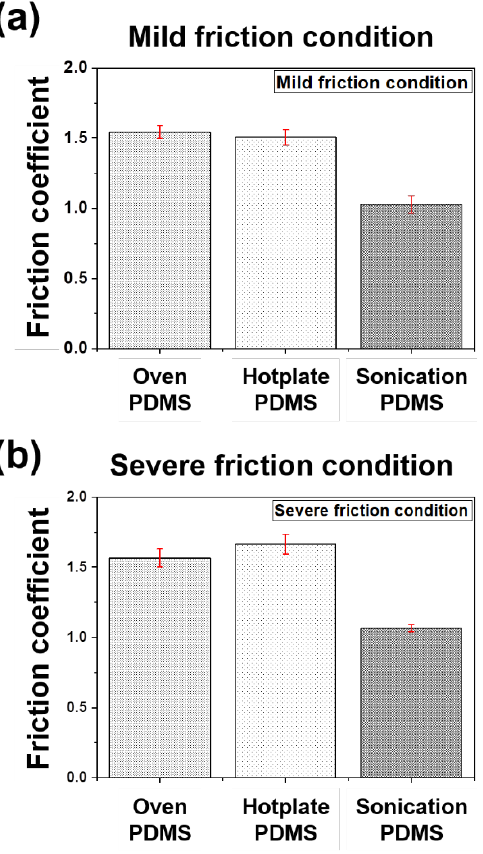
Figure 5. Average friction coefficients of the PDMS thin films under different curing methods. ( a ) mild friction condition (contact pressure: 0.5 MPa, sliding cycles: 120 cycles); ( b ) severe friction condition (contact pressure: 1 MPa, sliding cycles: 10,000 cycles).